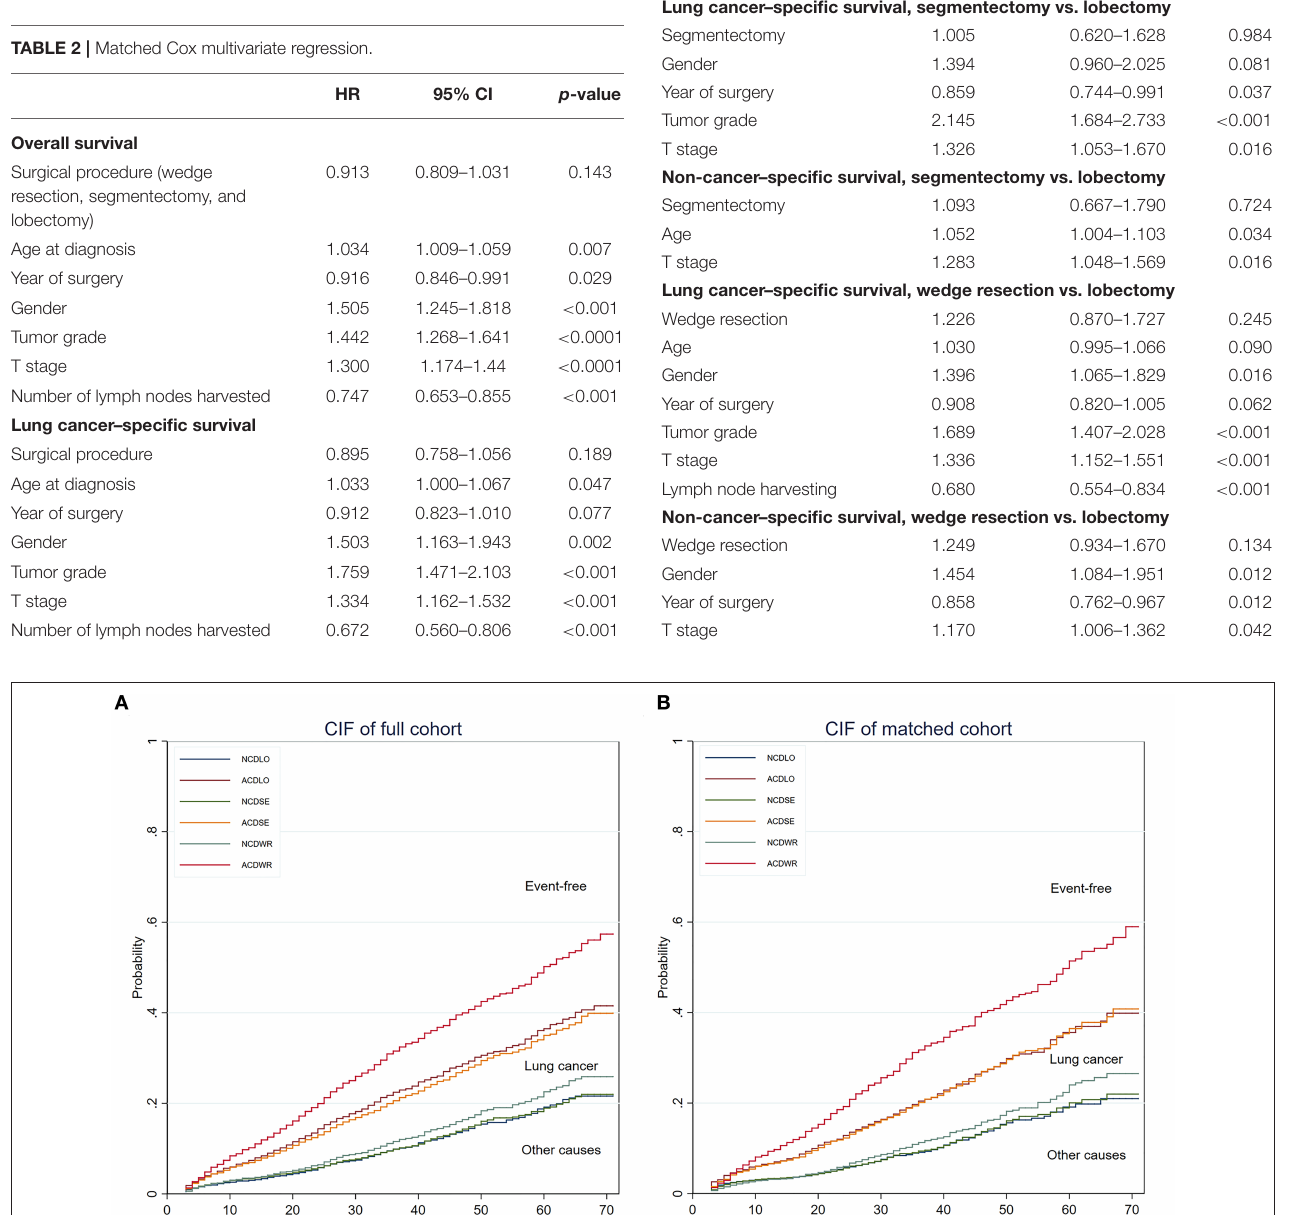
Frontiers in Surgery |